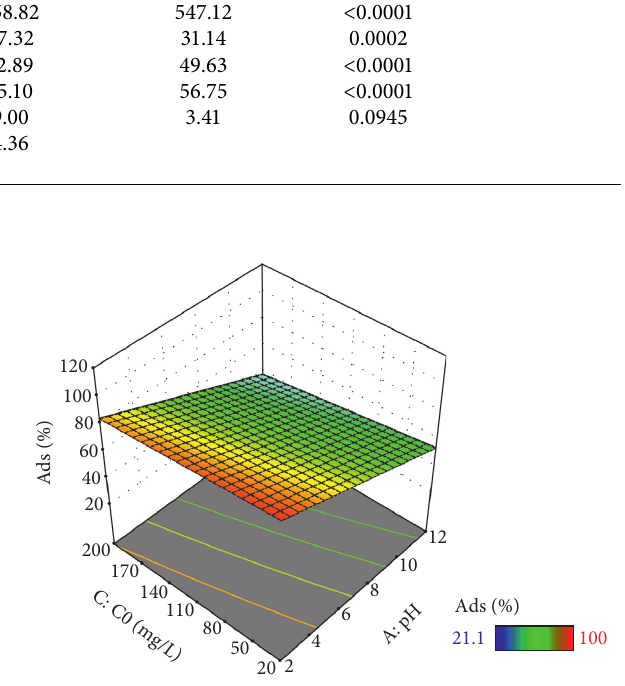
Figure 6: Surface responses plot for Ads% for the interaction pH- C